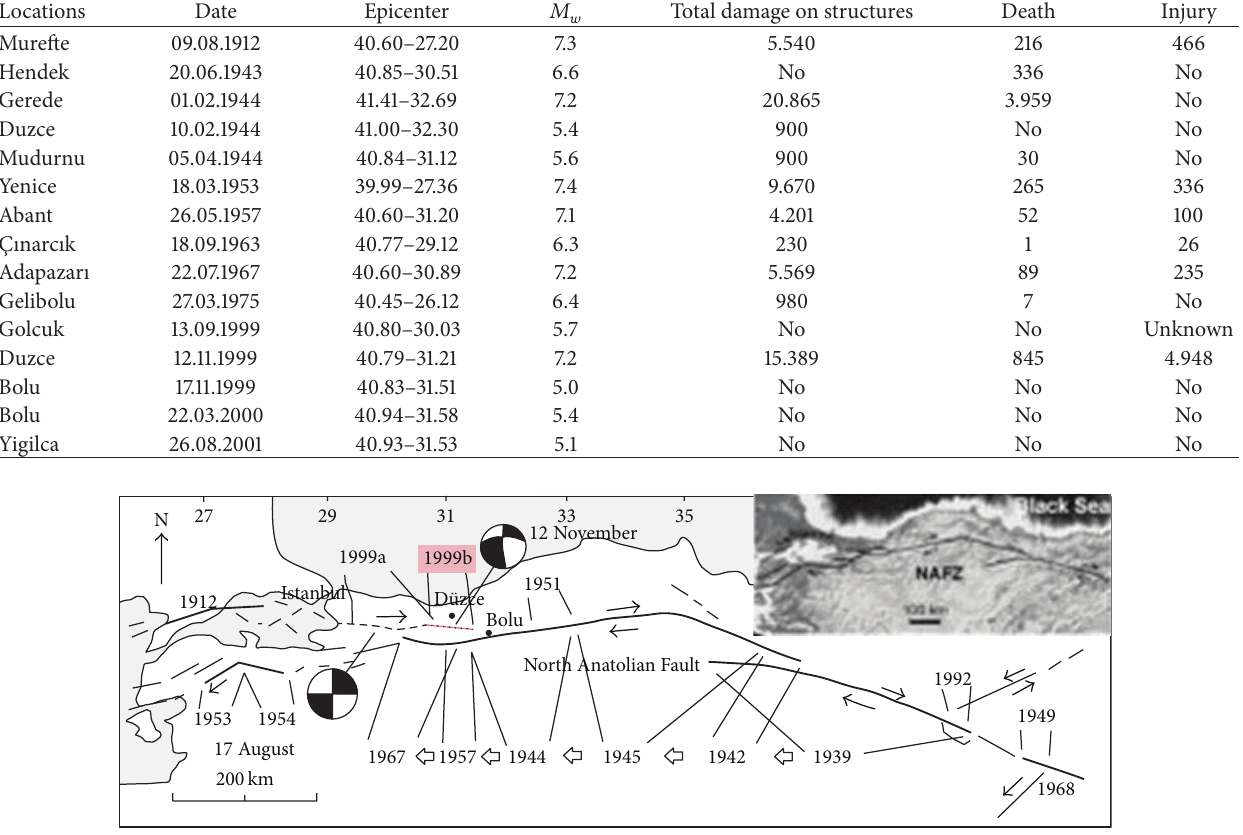
Table 1: Magnitude and damage records of earthquakes around the study area [24].